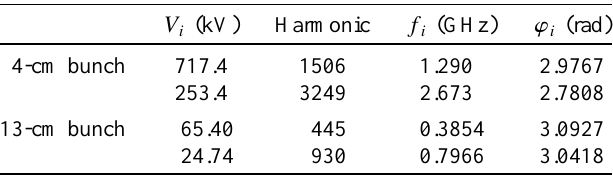
TABLE I. Two sinusoidal fits for potential-well compen- sation.